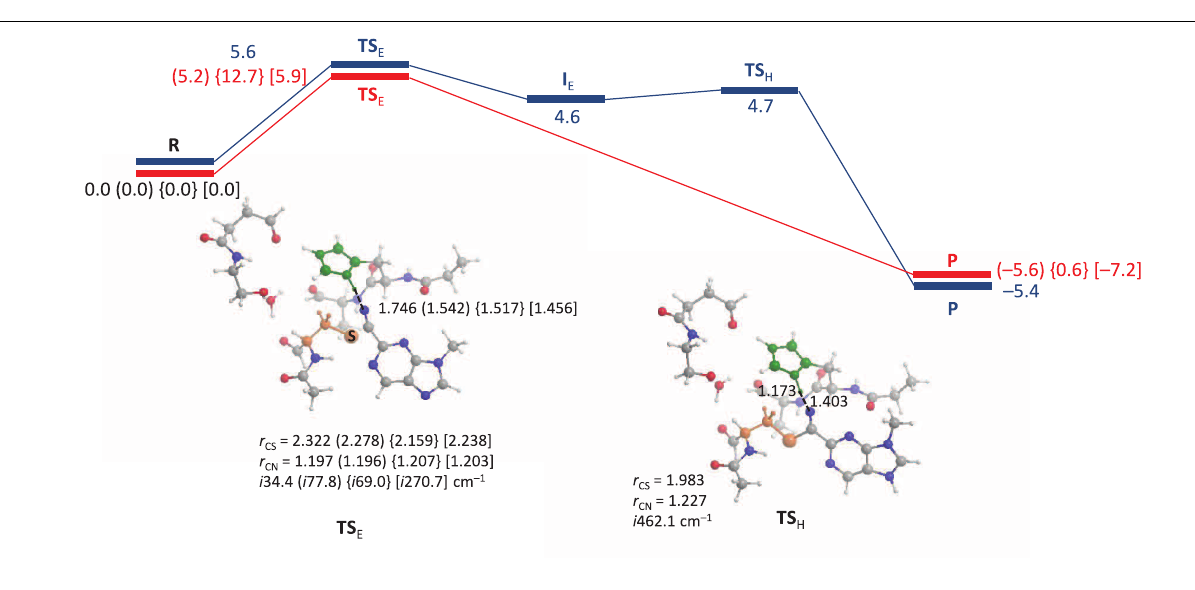
FIGURE 2 | QM-cluster calculations on the reaction mechanism of inhibition of substrate by cysteine protease. In blue we give the stepwise mechanism and in red the concerted mechanism. Bond lengths are given in